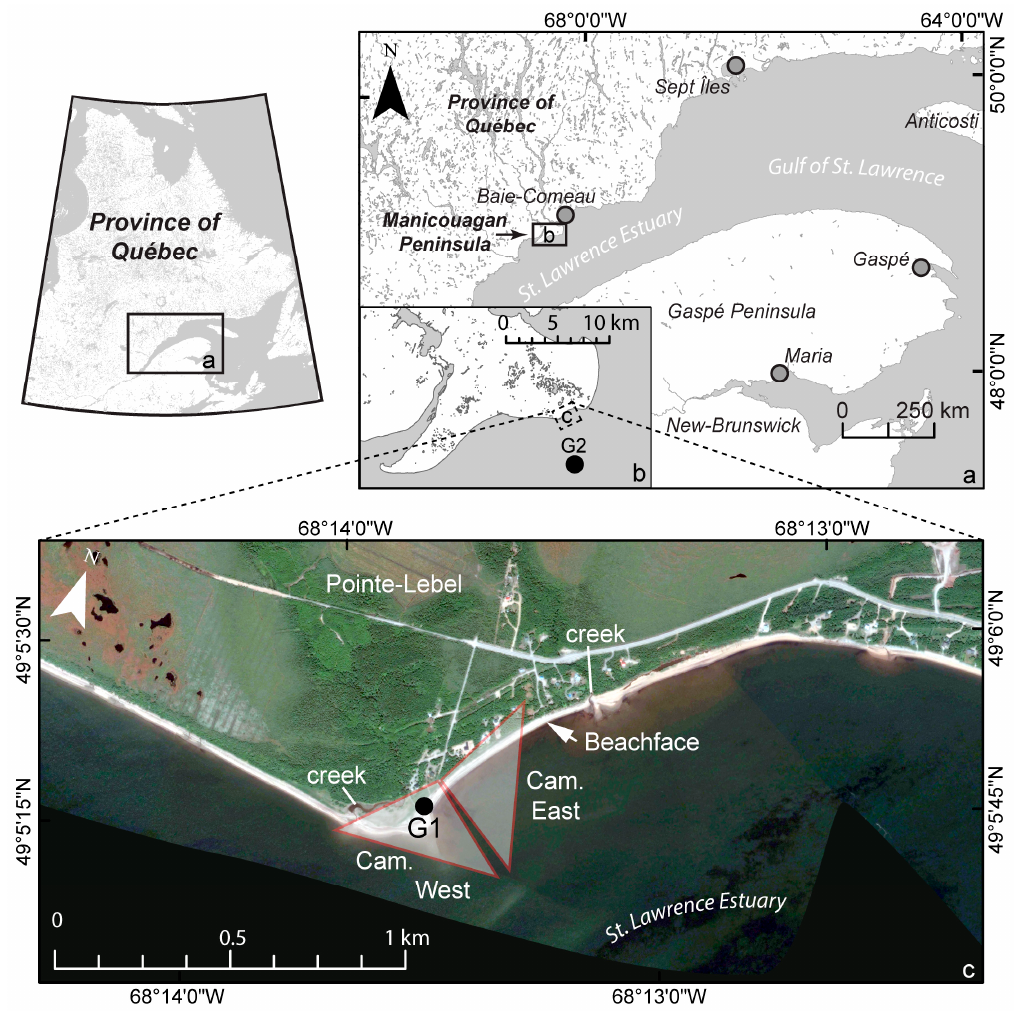
Figure 1. Location of the Manicouagan Peninsula ( a,b ) and of the monitoring station at Pointe-Lebel ( c ). Two video cameras are installed with 2 instruments (G1: nearshore pressure sensor logger; G2: offshore acoustic, wave and current meter (AWAC) for in-situ hydrodynamic acquisition (black circles) ( b , c )).